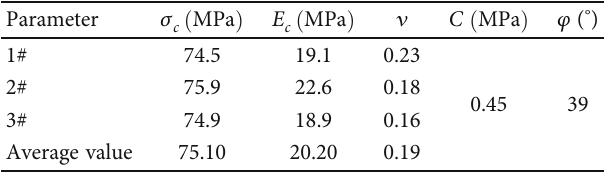
Figure 10: Process of deformation before the toppling failure. (a) The deformation feature of the cladding rock. (b) Deformation of mined- out areas and cracks on the top of the slope. (c) Dumping damage feature map. (d) Slope failure after instability. Table 1: Macroparameter values for limestone and fracture